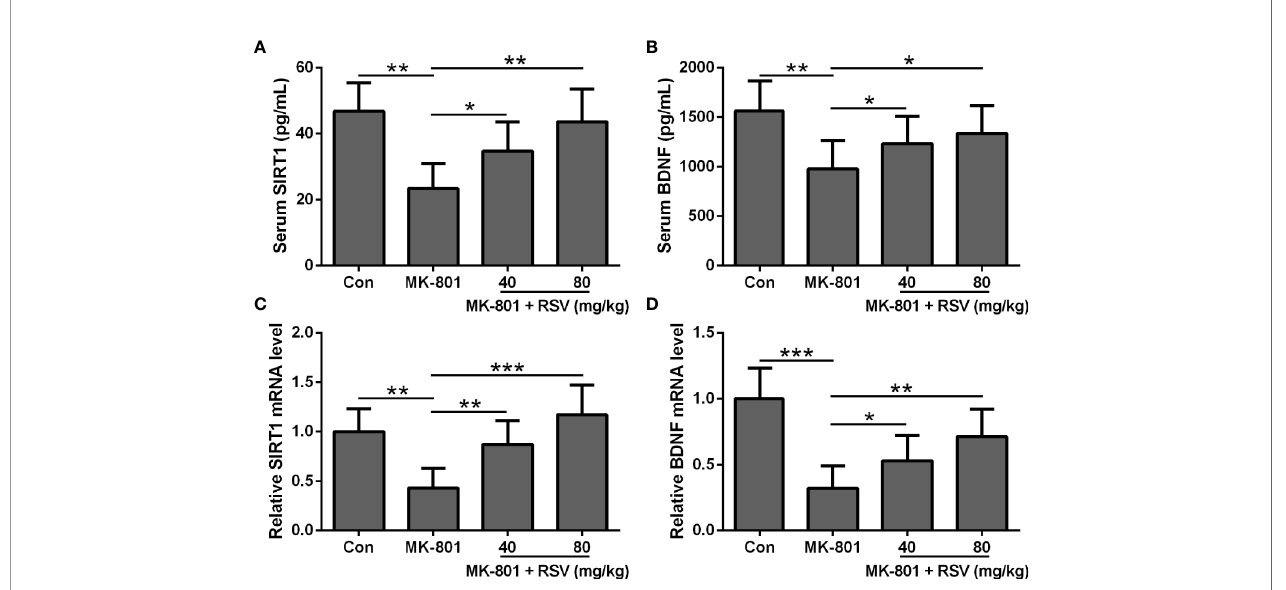
FIGURE 1 | RSV ameliorates the expressions of SIRT1 and BDNF in rat serum and hippocampus. ELISA was used to measure the concentration of SIRT1 (A) and BDNF (B) in serum. QRT-PCR was used to analyzed the mRNA levels of SIRT1 (C) and BDNF (D) in hippocampus. GAPDH was set as a loading control and the relative expressions were normalized to control group. n = 6 in each group. Data were presented as mean ± SD. F ratios: (A) 11.39 (3.00, 17.43), (B) 5.783 (3.00, 21.06), (C) 13.33 (3.00, 18.60), (D) 16.40 (3.00, 12.70). *p < 0.05, **p < 0.01, and ***p < 0.001 between the indicated